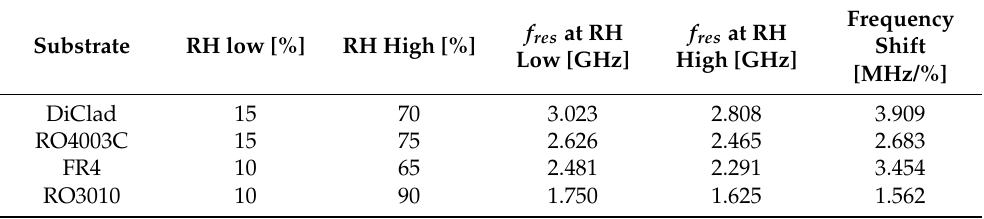
Table 3. Performance comparison in terms of frequency shift [MHz/%] of the chipless humidity sensor proposed on the different substrates.